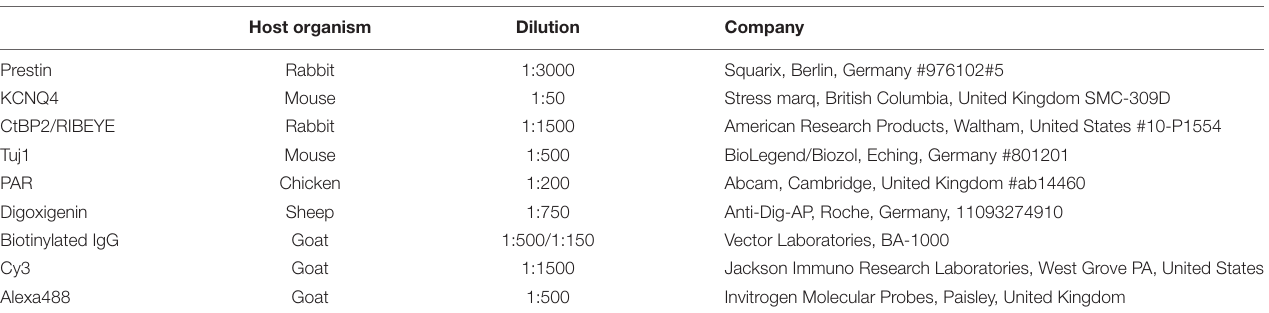
TABLE 3 | Antibodies for